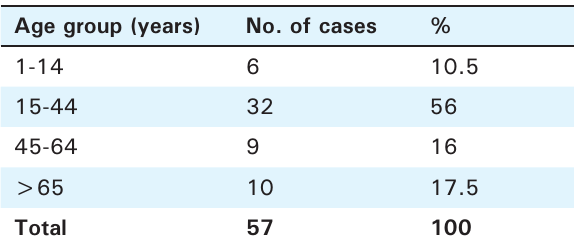
Table 1. Age distribution of patients with FUO